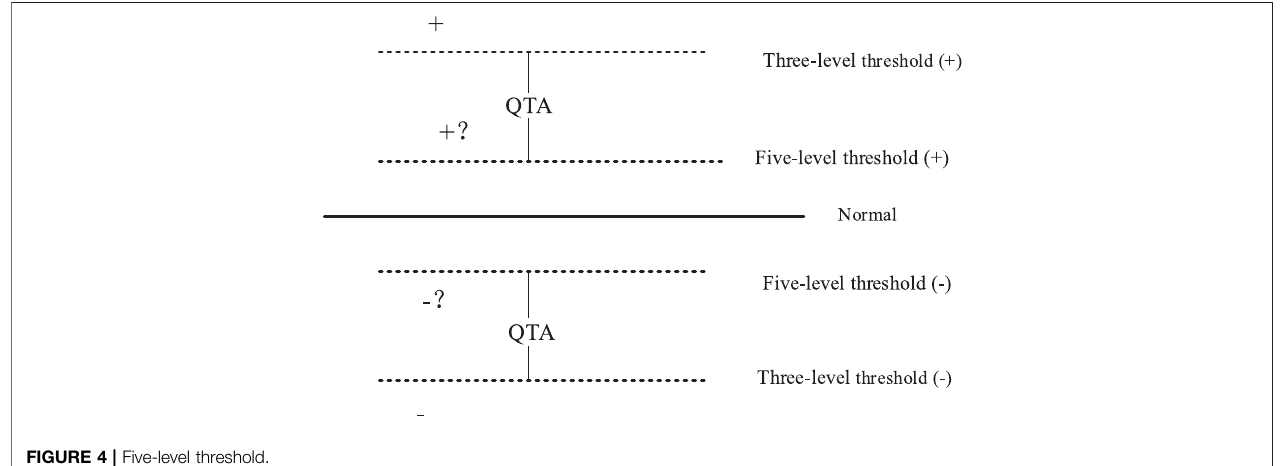
FIGURE 4 | Five-level